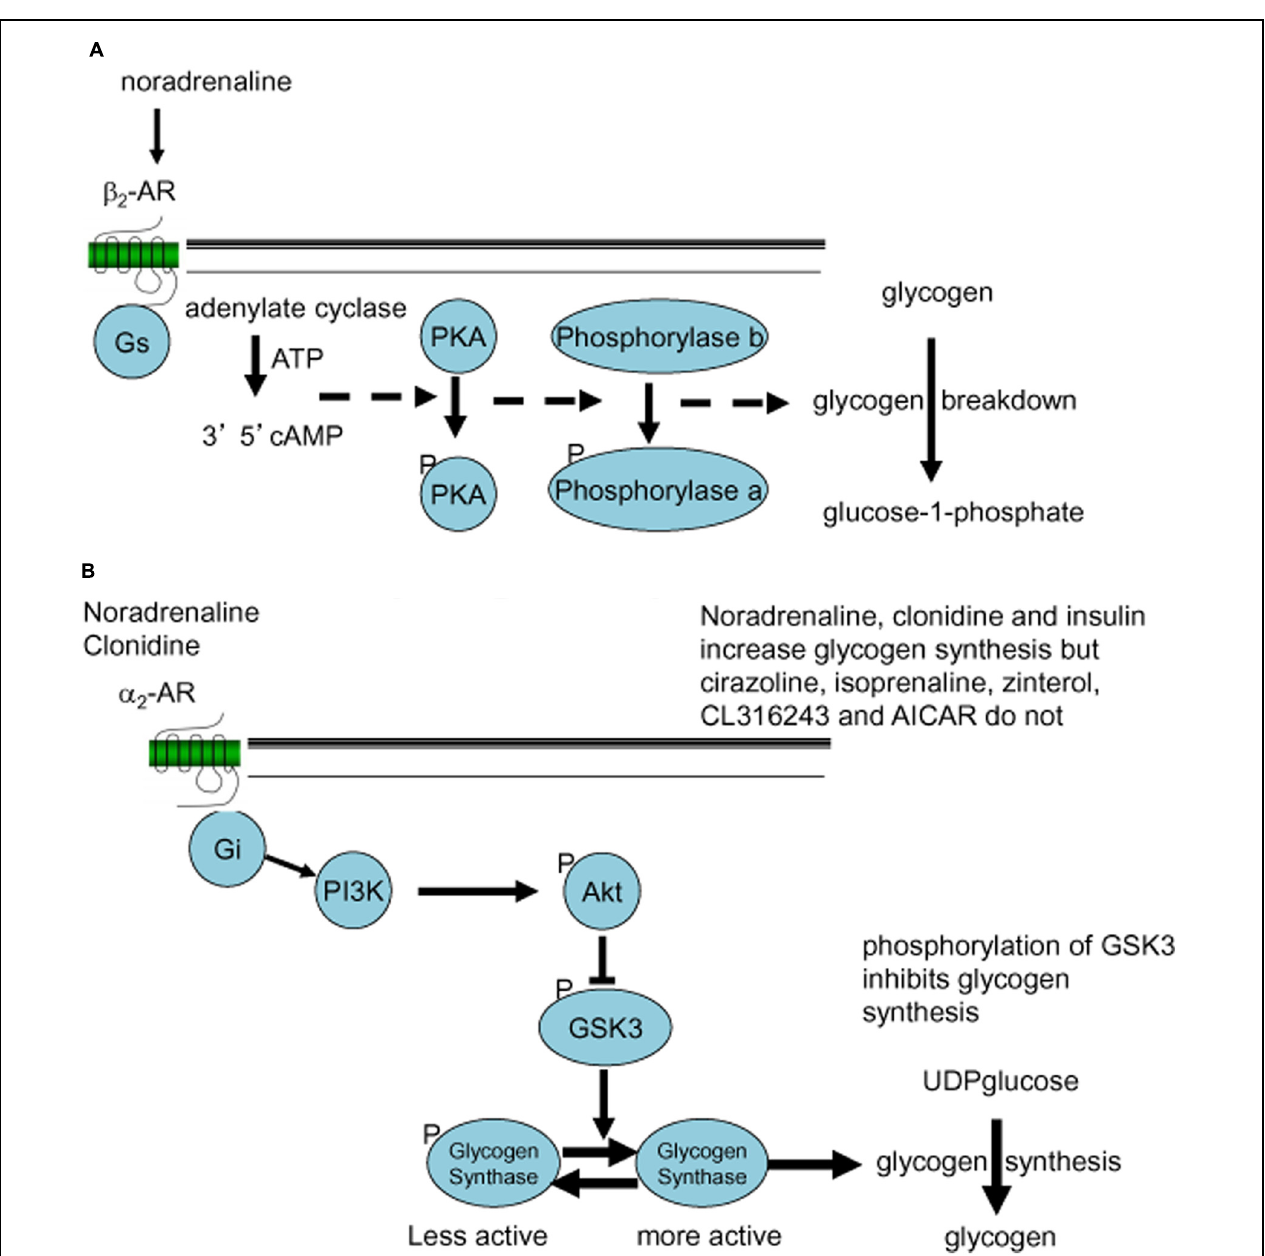
FIGURE 7 | Noradrenergic signaling stimulating glycogenolysis (A) or glycogen synthesis (B). (A) β 2 -Adrenergic G s -mediated formation of cAMP and phosphorylation of proteinkinase A (PKA) leads to conversion (phosphorylation ) of phosphorylase b to the active phosphorylase a, which stimulates glycogen breakdown (conversion of glycogen to glucose-1-phosphate). (B) α 2 -Adrenergic G i -mediated stimulation of the PI3K-AKT pathway leads to phosphorylation of glycogen synthase kinase (GSK) and dephosphorylation of glycogen synthase, which stimulates glycogen synthesis (incorporation of UDPglucose into